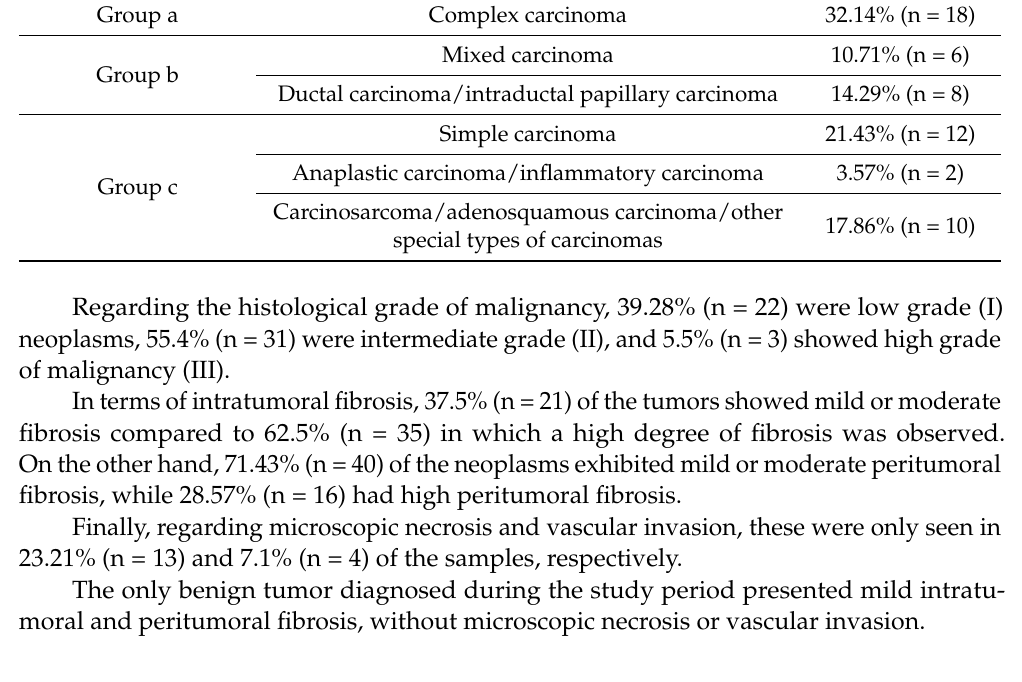
Table 1. Histological diagnosis of malignant mammary neoplasms. Histological